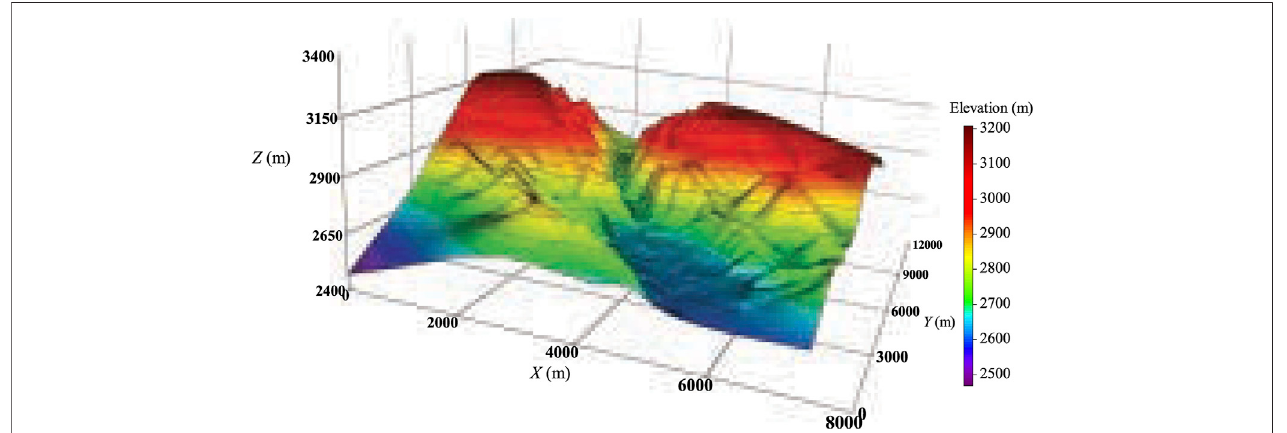
FIGURE 7 | Topographic map of the Nanmenxia